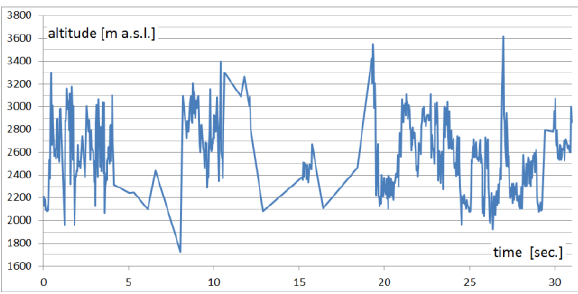
Fig. 10. Graph of observed elevations during task (variant A, task 4, participant no.